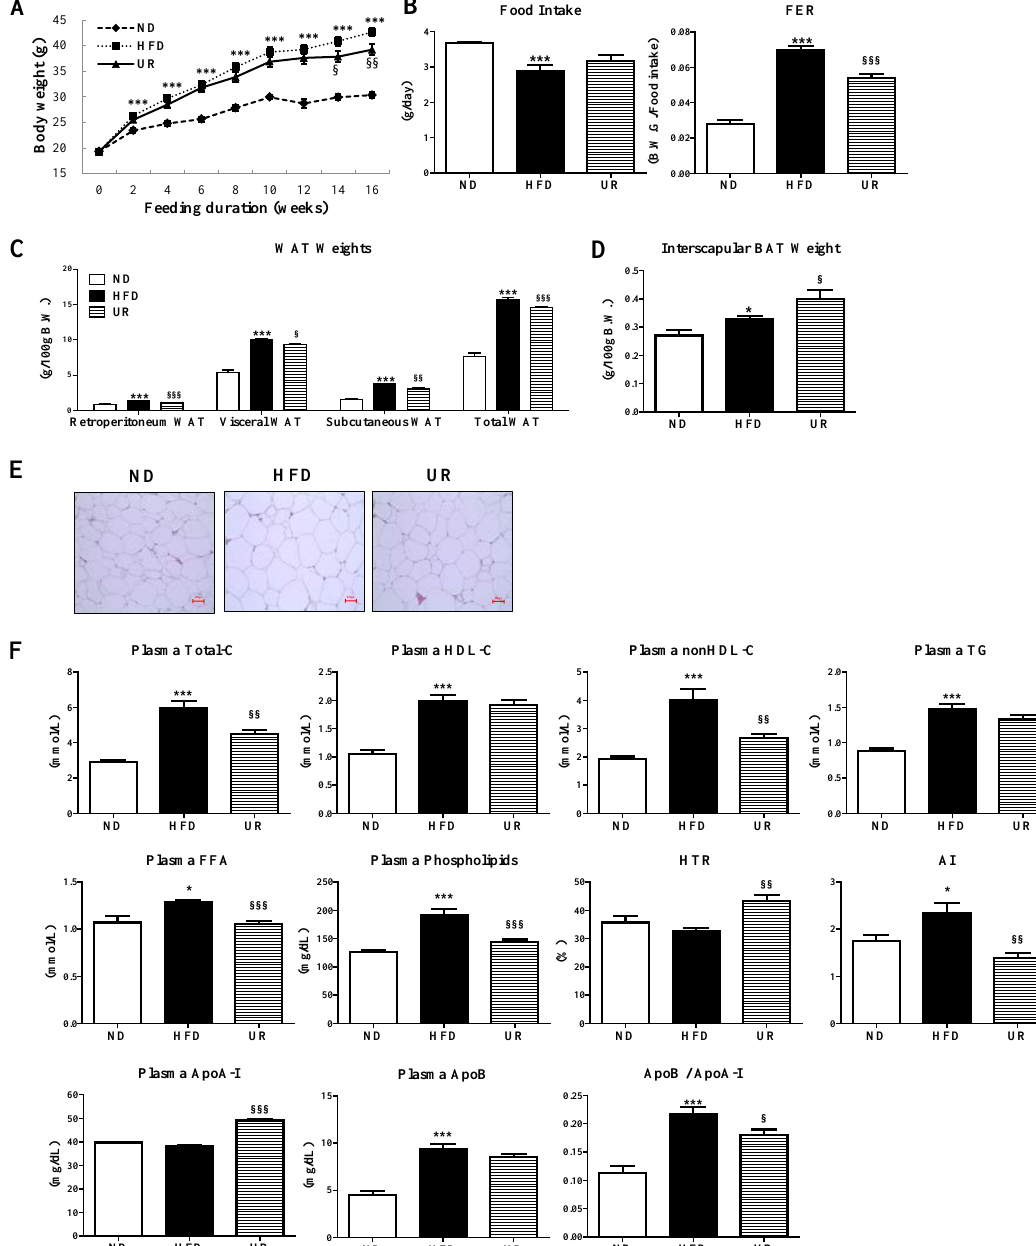
Figure 1. Effect of ursolic acid (UR) treatment on changes: in body weight (BW) ( A ); food intake and food efficiency ratio ( B ); white adipose tissue (WAT) weights ( C ); brown adipose tissue (BAT) weight ( D ); WAT morphology (magnification × 200) ( E ); and plasma lipid levels ( F ) in C57BL/6J mice fed a high-fat diet (HFD; 20% fat, 1% cholesterol). Data are shown as means ± SEM. Normal diet (ND; AIN-76) vs. HFD; * p < 0.05, ** p <0.01, *** p < 0.001. HFD vs. UR (HFD + 0.05% UR); § p < 0.05, §§ p < 0.01, §§§ p < 0.001. FER, food efficiency ratio, body weight gain/energy intakes per day; WAT, white adipose tissue; BAT, brown adipose tissue; Total-C, total-cholesterol; HDL-C, HDL-cholesterol; TG, triglyceride; FFA, free fatty acid; HTR, ratio of HDL-C to TC; AI, atherogenic index; Apo, apolipoprotein.